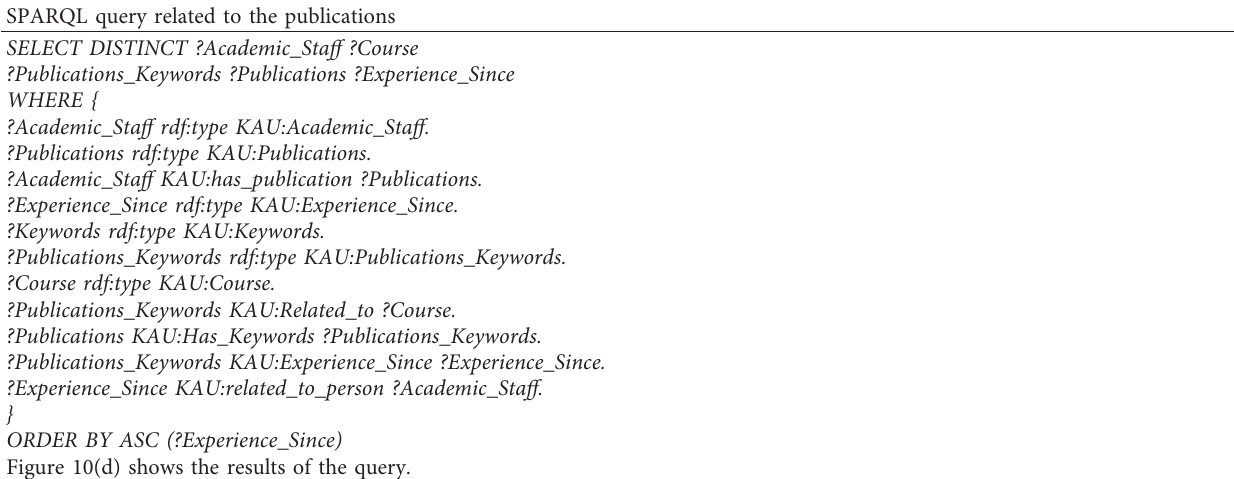
Table 12: The publications example after